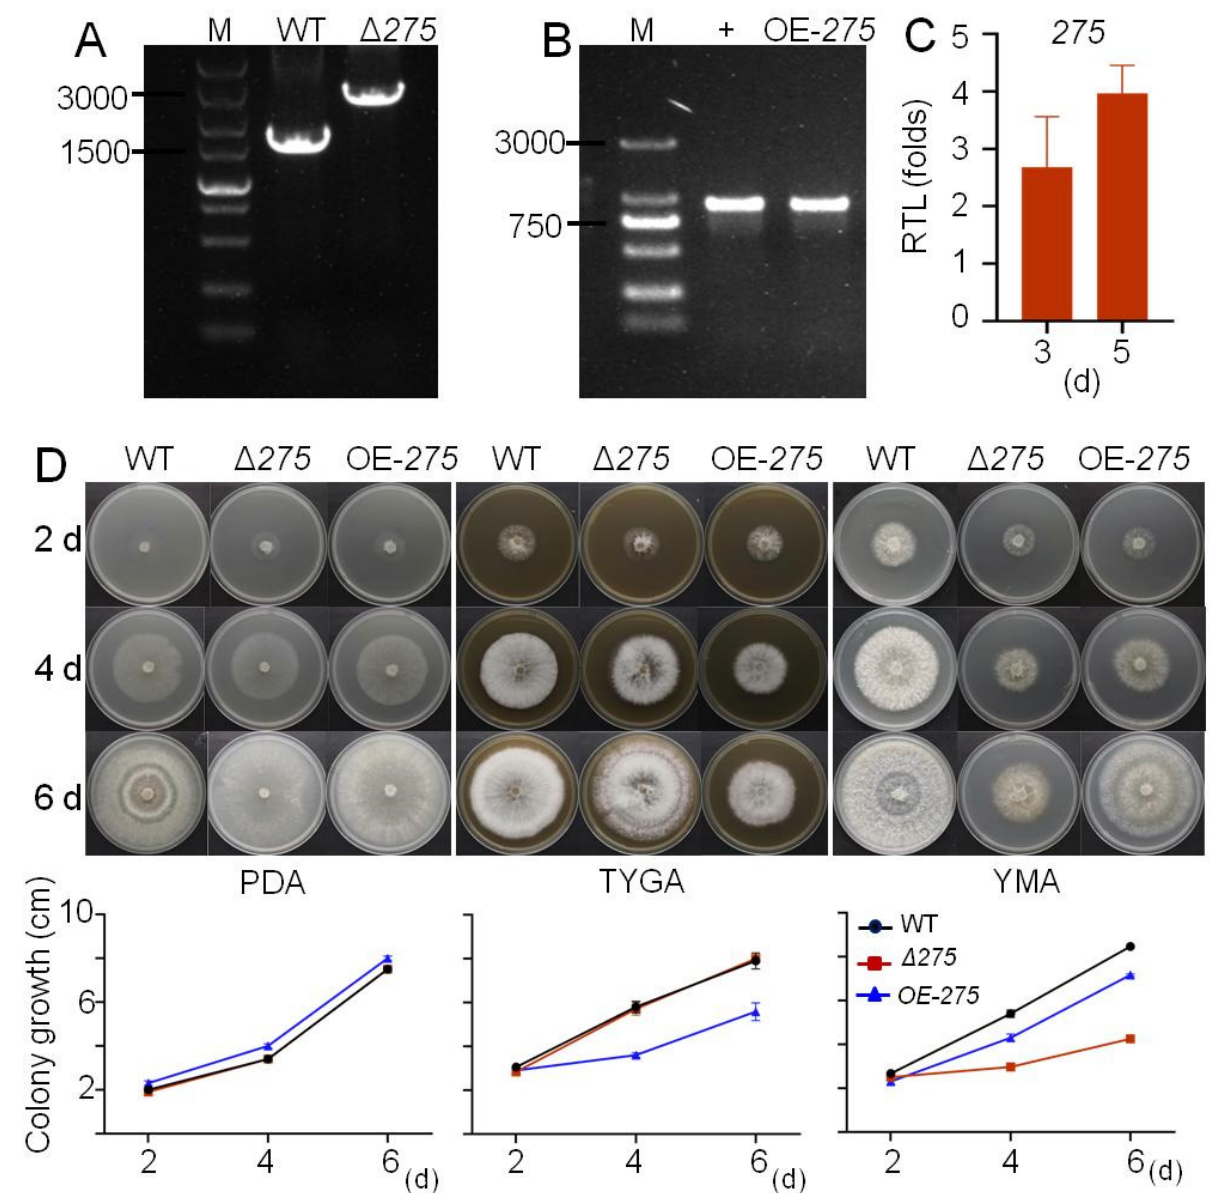
Figure 2. Confirmation of the mutant Δ 275 with the disruption of 275 and the mutant OE- 275 with the strong promoter replaced, and comparison of the colony growth of these two mutants with the WT on three media: ( A , B ) PCR analysis confirmed the mutants Δ 275 ( A ) and OE- 275 ( B ). ( C ) The relative transcriptional level (RTL) of 275 in the mutant OE- 275 at 3 and 5 days compared to that in the WT. ( D ) Comparison of the colony growth of these two mutants with the WT on three media (PDA, TYGA, and YMA).